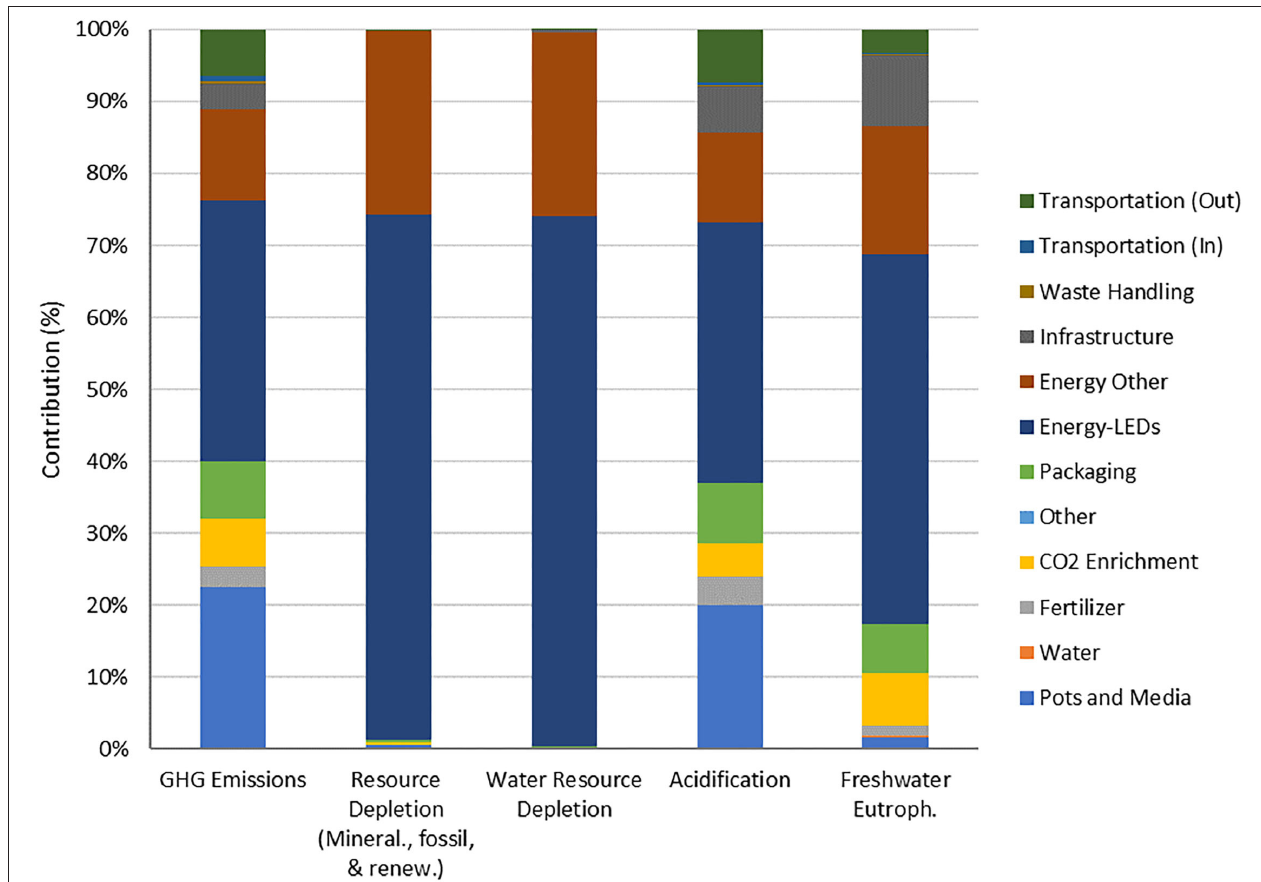
FIGURE 3 | Contribution of different processes to the annual environmental impacts in the Reference Scenario, shown in the contribution (percentage) to each impact